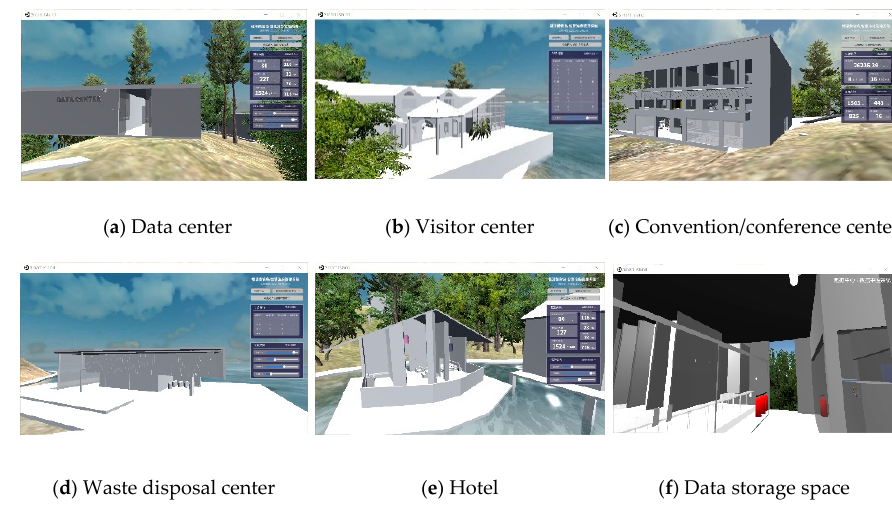
Figure 7. SVSMS using virtual reality in Huangguan Island: ( a ) Data center; ( b ) Visitor center; ( c ) Convention/conference center; ( d ) Waste disposal center; ( e ) Hotel; ( f ) Data storage space.